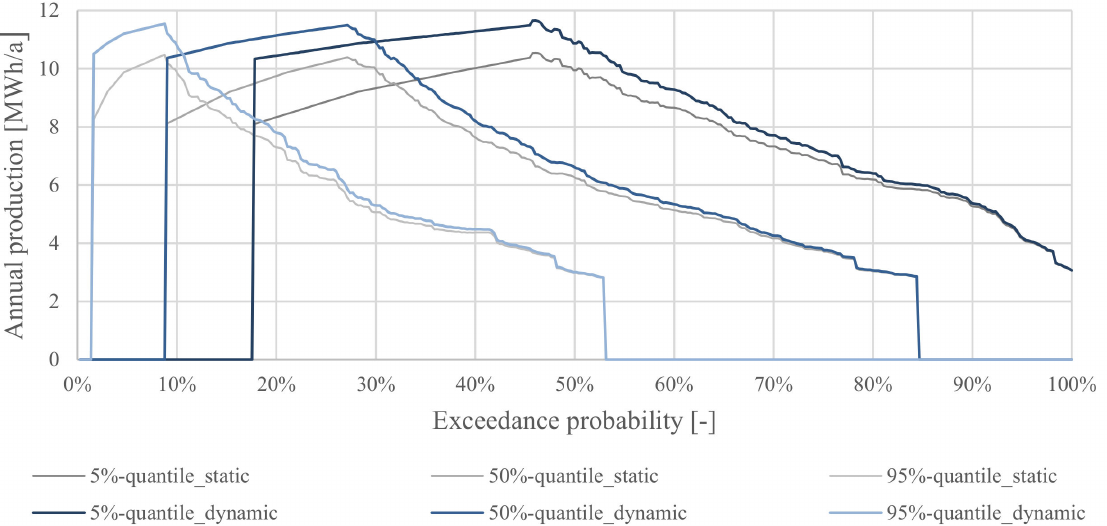
Figure 5. Comparison of the annual production of a static and a dynamic water level regulation with probability of occurrence